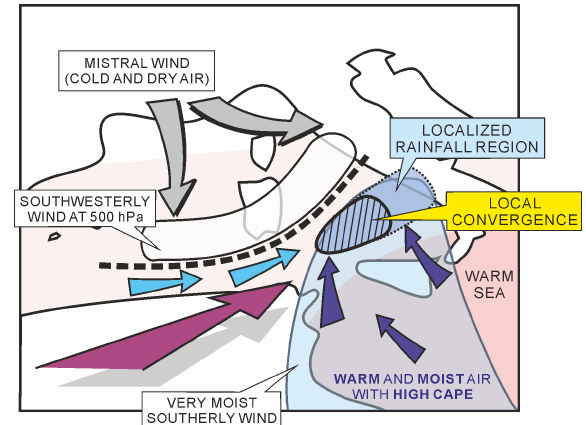
Figure 8. Schematics summarizing the main features and processes responsible for the maintenance of deep convection upstream of southern Italy and leading to HPEs for Period 1 of HyMeX IOP13. Grey arrows indicate the mistral wind behind the edge of the cold front (thick dashed line). The light blue arrows depict the low- level westerlies to southwesterlies ahead of the front. Dark blue ar- rows show the low-level moist southerlies from the eastern Mediter- ranean encompassed in the blue-shaded area. The purple arrow il- lustrates the elevated tropical plume. The local low-level conver- gence is indicated by a hatched area. The rainfall regions are indi- cated by blue shading within the dotted line (from Lee et al.,